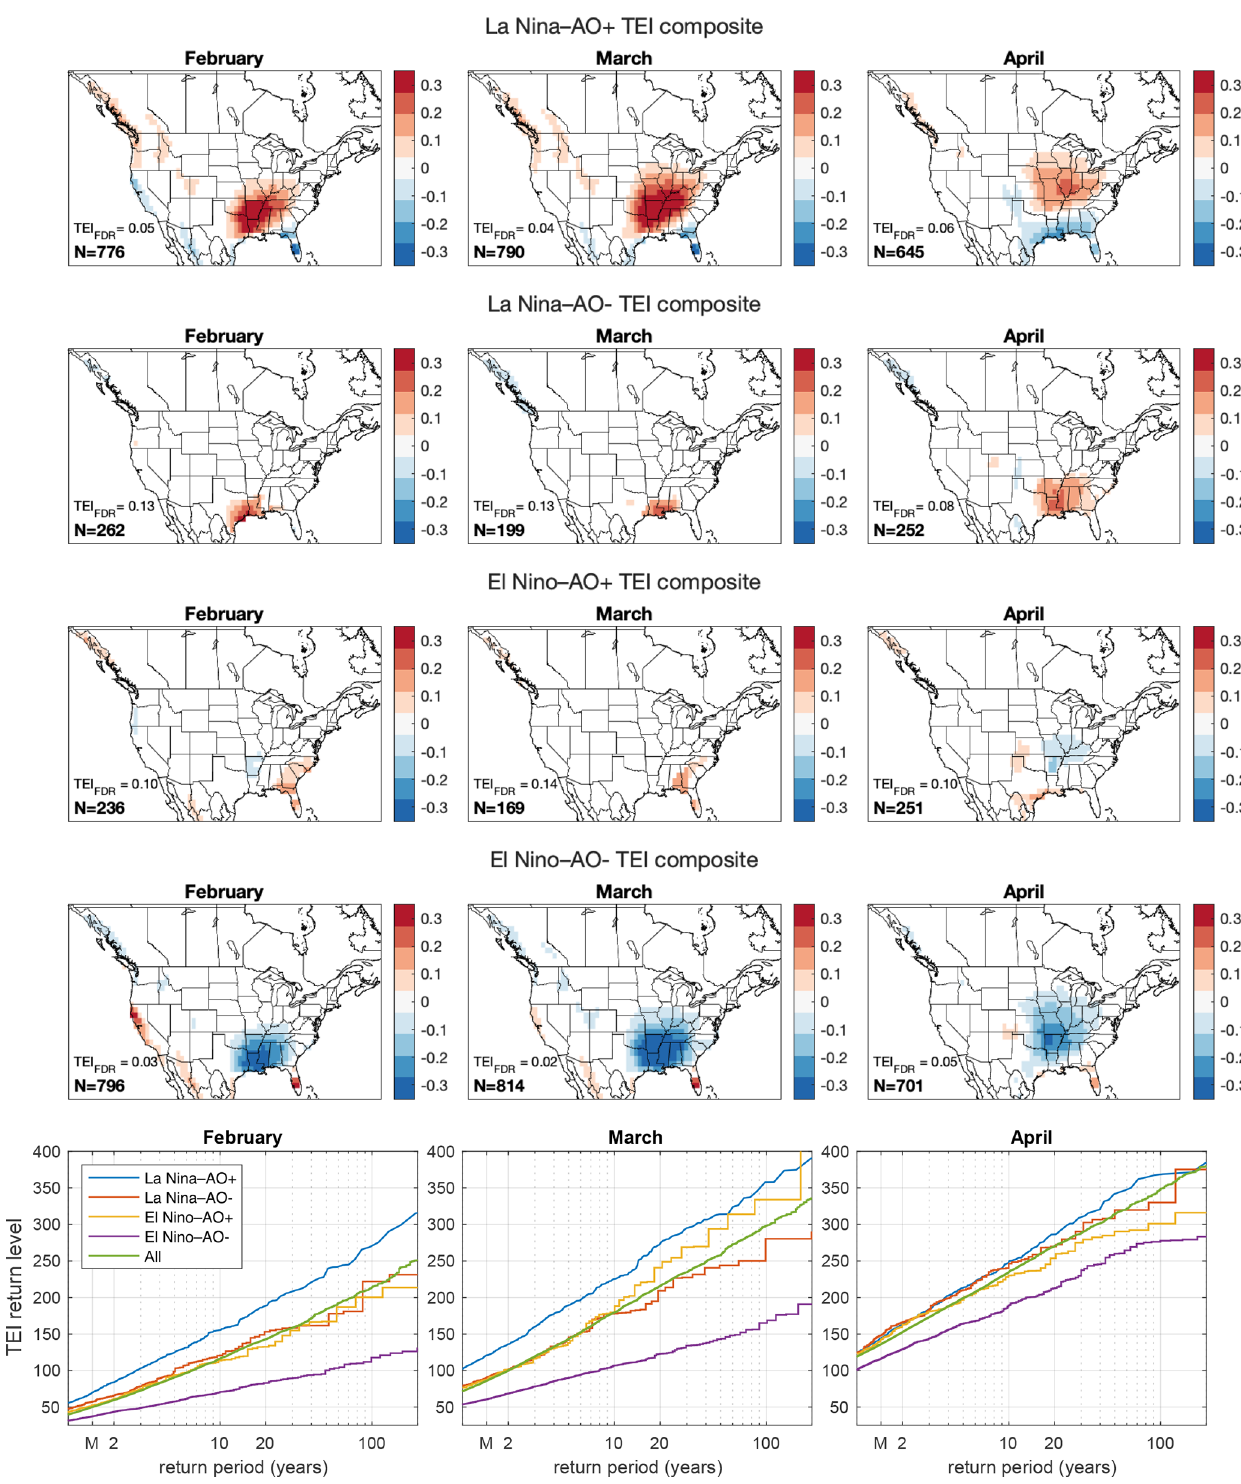
Figure 2. Rows 1–4: bivariate Niño 3.4–AO composites of February, March, and April TEI anomalies. TEI units are number of tornado reports per 1 × 1 grid box. The sample size for each case is indicated in the lower left corner. All statistically insignificant values have amplitudes less than TEI FDR , which is shown on each map. Statistically insignificant values and values with absolute values less than 0.05 are masked. Bottom row: summed (land points east of 110 ◦ W) TEI return levels and approximate return periods conditional on bivariate Niño 3.4–AO phase. “M” marks the approximate return period of the